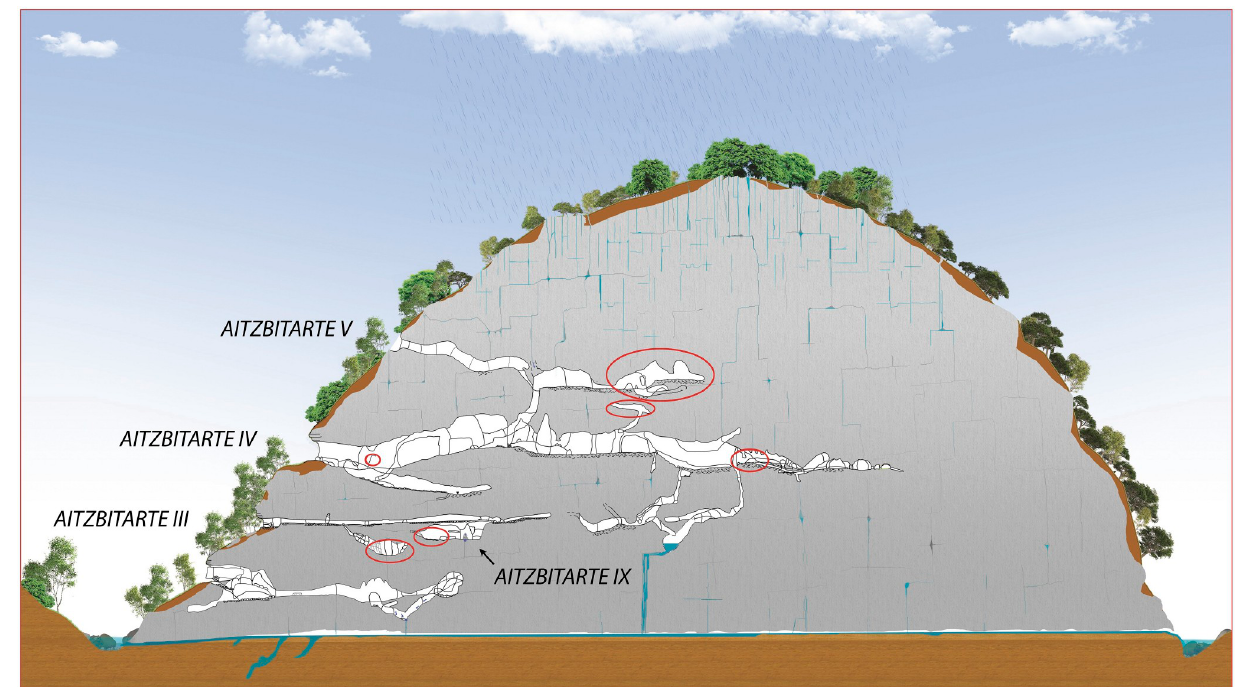
Fig 2. Cross-section though Aitzbitarte hill showing the main speleological phenomena. The decorated sectors are indicated with a red circle (Felix Ugarte Elkartea).